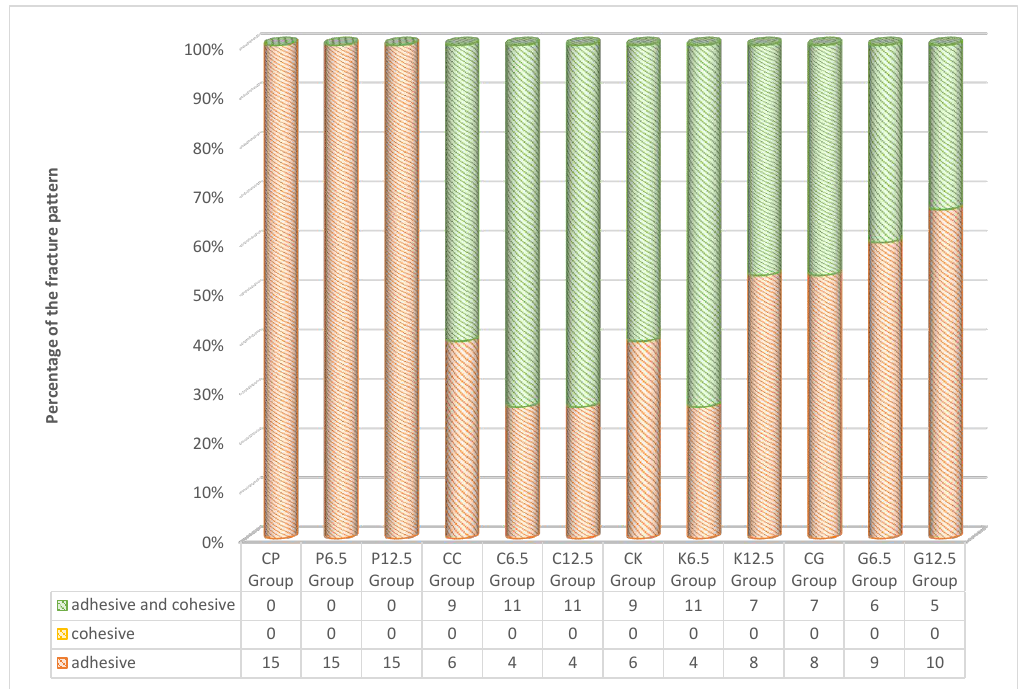
Figure 3. Failure modes of groups after the shear bond strength test.